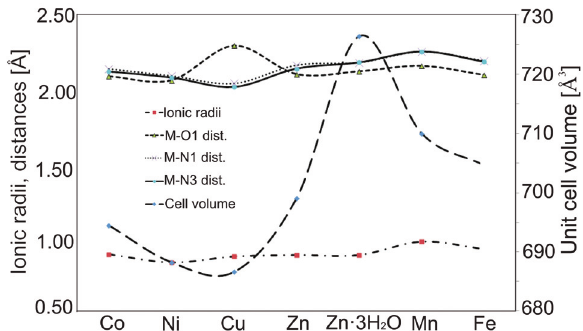
Figure 2. The unit cell volume and M–N and M–O distances [ Å ] relation with the central metal ion and its radius. The unit cell volu- mes are normalized.